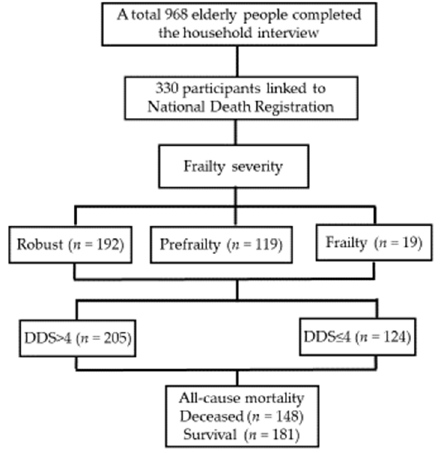
Figure 1. Flow chart for participant selection.